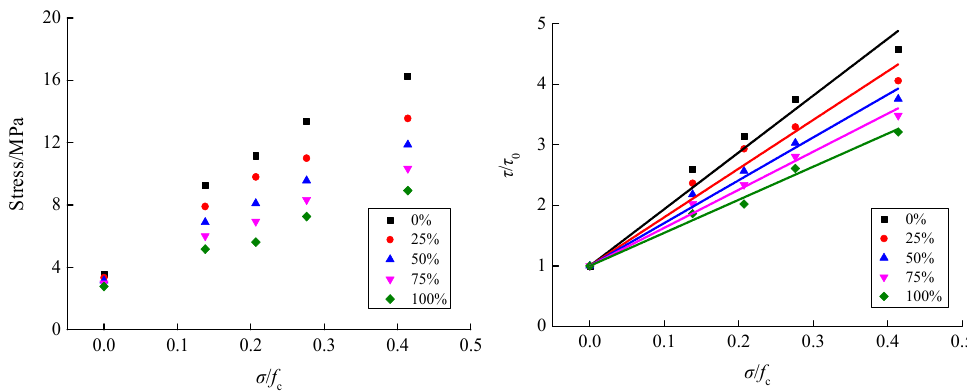
Figure 5. Variation trend of the influence of axial compression ratio on the shear stress of recycled concrete.